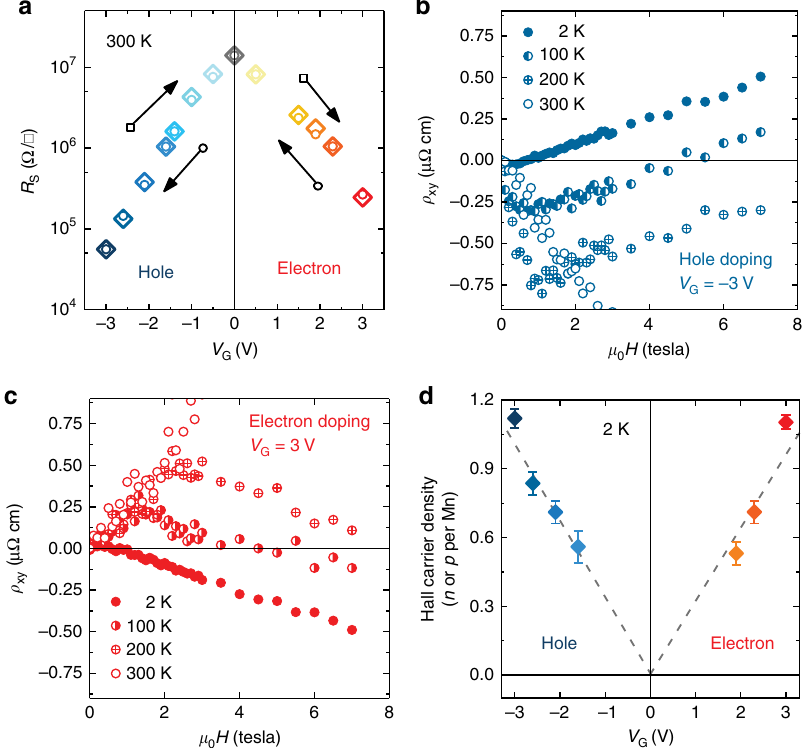
Fig. 2 Transport properties of 3 uc LaMnO 3 fi lm at various gate voltages ( V G ) and temperatures. a The sheet resistance as a function of V G at 300 K. No loop is seen, indicating that effects of oxygen migration are negligible. b , c Hall resistivity ( ρ xy ) of LaMnO 3 under of V G = − 3 V ( b ) and 3 V ( c ) at different temperatures. temperatures. Due to the presence of high noise levels in ρ xy (300 K) for magnetic fi eld above 3 Tesla, the high- fi eld data of ρ xy at 300 K are omitted. d Hall carrier density expressed in electron or hole content per Mn site based on the Hall results at 2 K and various V G . The error bars at these V G were calculated based on the fl uctuation of ρ xy within the ordinary Hall effect (OHE) region at 2